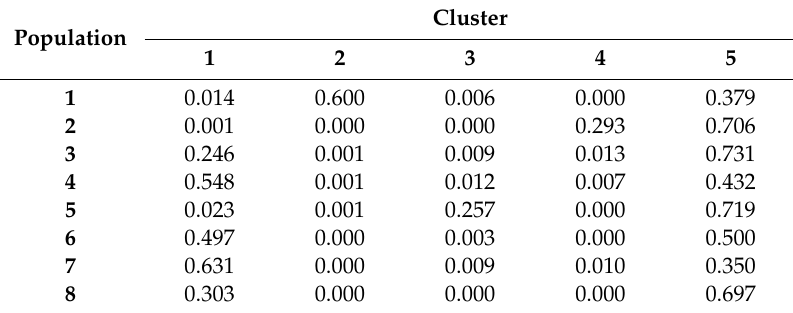
Table 2. Percentages of the clusters identified in the studied samples at K =